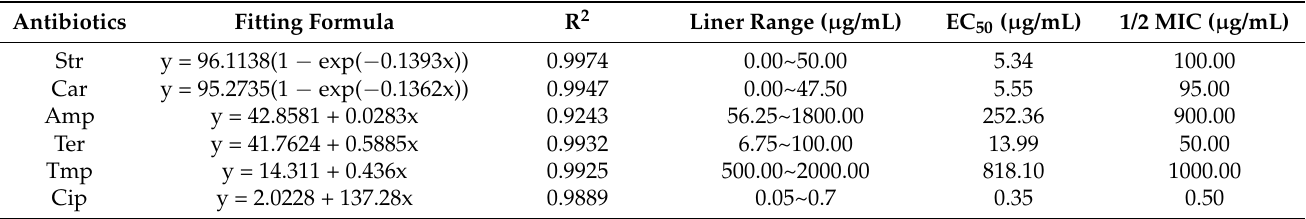
Table 1. Comparative results between the PAO1-CE biosensor and MIC